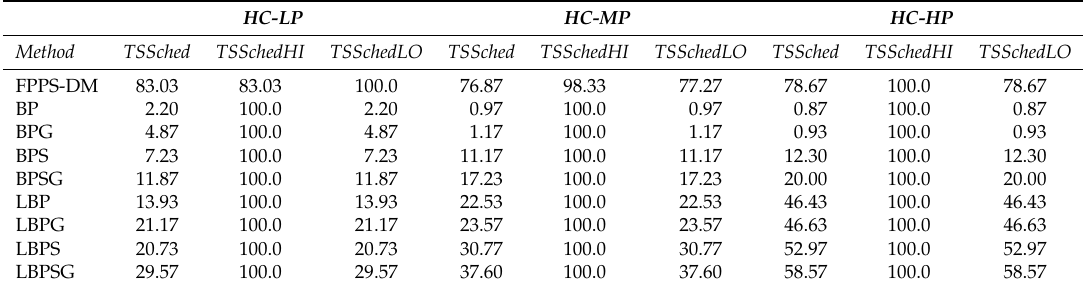
Table 1. BP and LBP variants: comparison of task set schedulability (%).